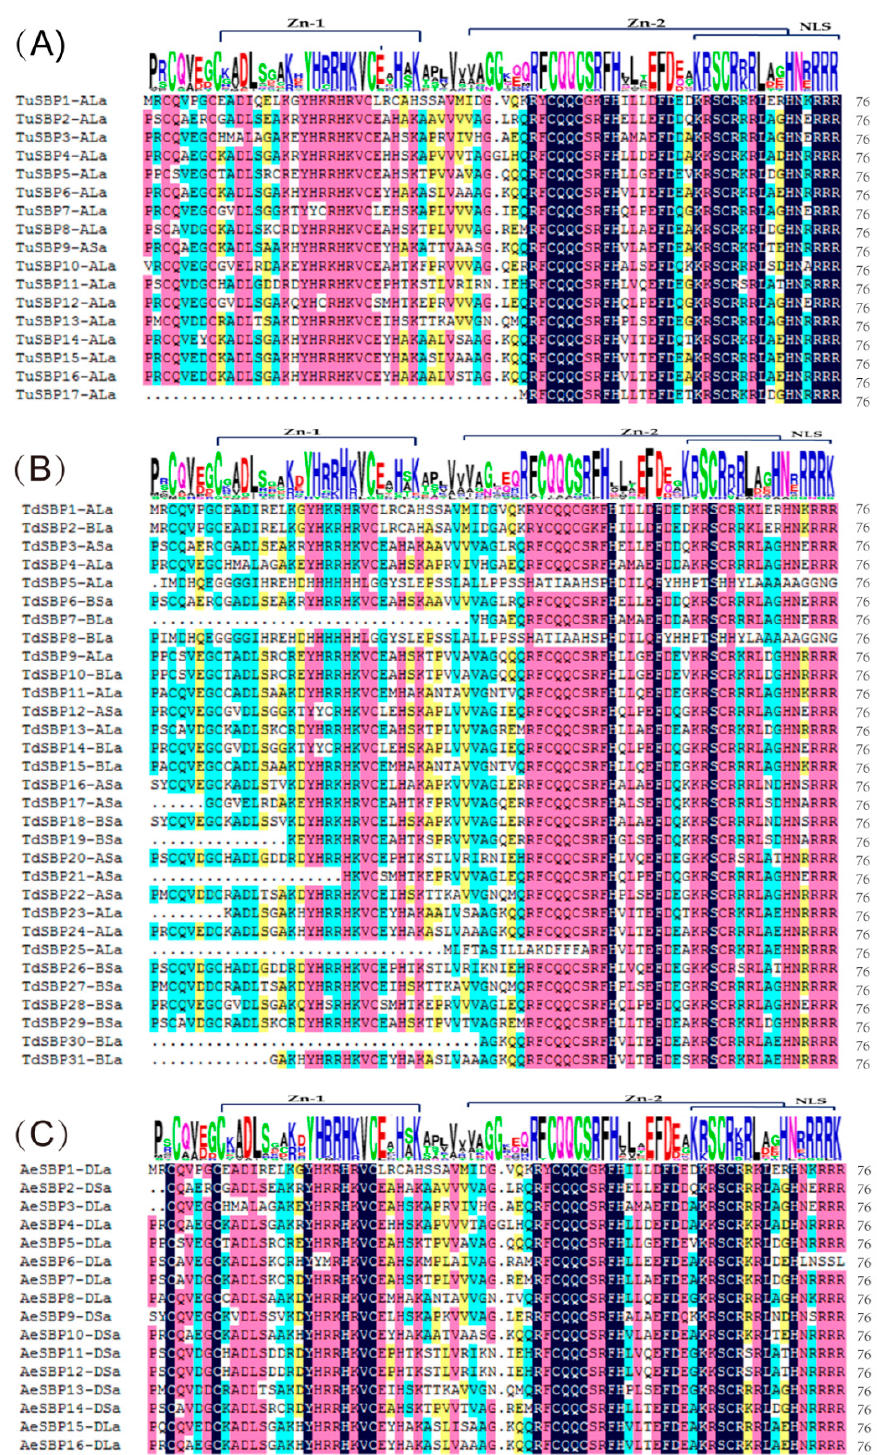
Figure 14. SBP-domain alignment of TuSBPs, TdSBPs, and AeSBPS: ( A ) SBP-domain alignment of TuSBPs; ( B ) SBP-domain alignment of TdSBPs; and ( C ) SBP-domain alignment of AeSBPs. Multiple alignment of the SBP domains of the SBP protein sequences was obtained by DNAMAN6.0 software. Sequences LOGO view based on the result of sequence alignment was placed at the top of the figure. Zinc-binding sites and NLS structure are also labeled. Different colors represent the conservative degree of amino acids: black, 100% conserved; amaranth, 75–100% conserved; light blue, 50–75% conserved; yellow, 33–50% conserved; white, less than 33% conserved.